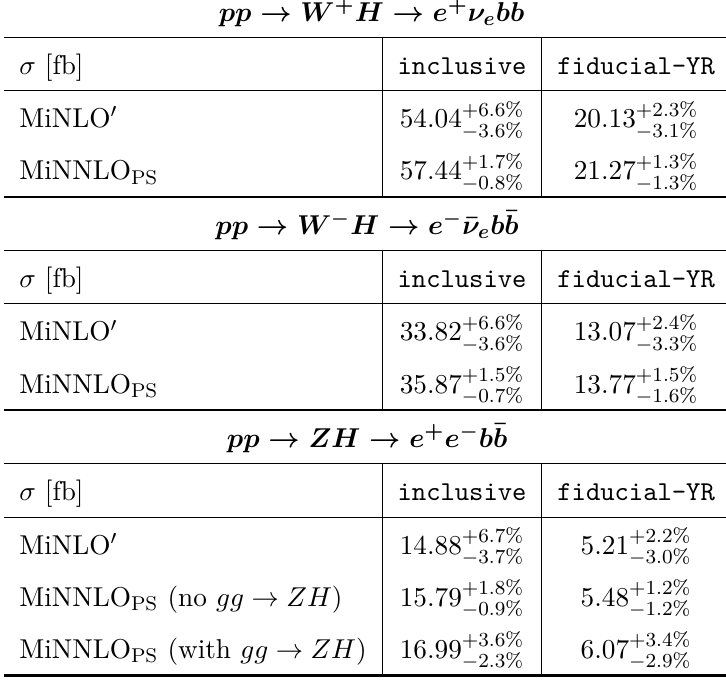
Table 3 . Integrated cross sections for the e + ν e b ¯ b , e − ¯ ν e b ¯ b and e + e − b ¯ b final states in the inclusive and the fiducial-YR